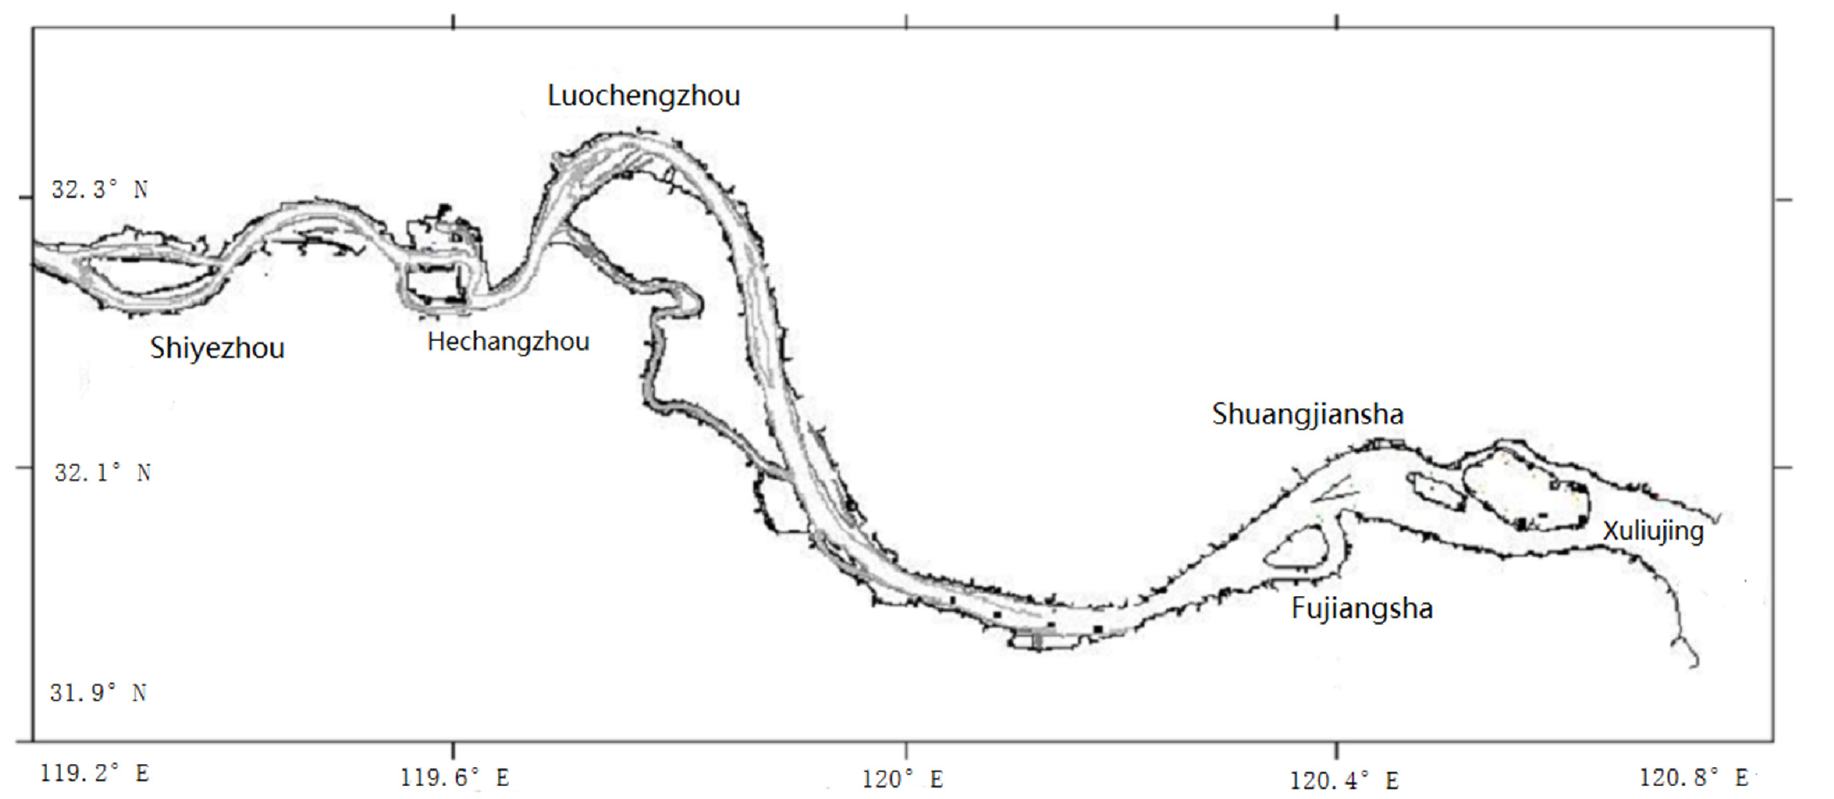
Figure 8. Locations of waterways in the 12.5 m deep-water channel below Nanjing of the Yangtze